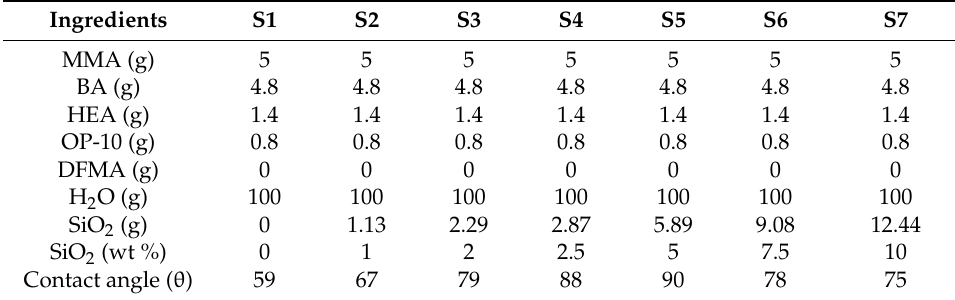
Table 1. Recipes for modified Nano-SiO 2 /polyacrylate emulsion without fluorine.